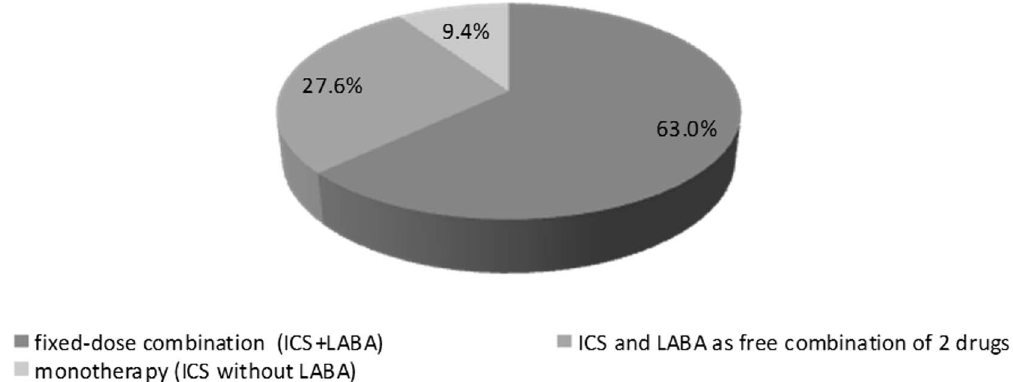
Figure 5. Use of ICS in monotherapy or combination therapy.